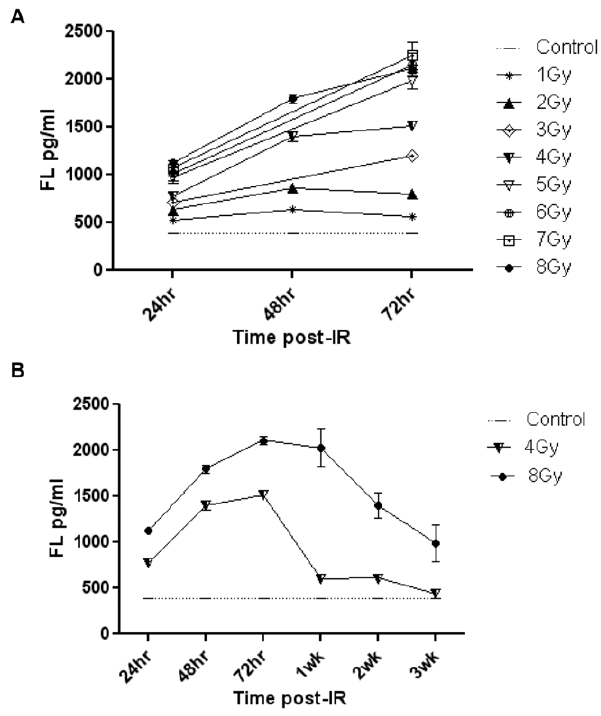
Figure 1. FL Levels Following TBI. FL levels correlate with dose of irradiation and time of collection. A) Plasma FL levels in TBI C57BL6 mice at 24, 48 and 72 hrs post-IR at doses between 0 and 8 Gy. B) Extended time course of plasma FL expression in TBI C57BL6 mice at 0, 4 and 8 Gy at time points between 24 hrs and 3wks post-IR. Values reflect the mean 6